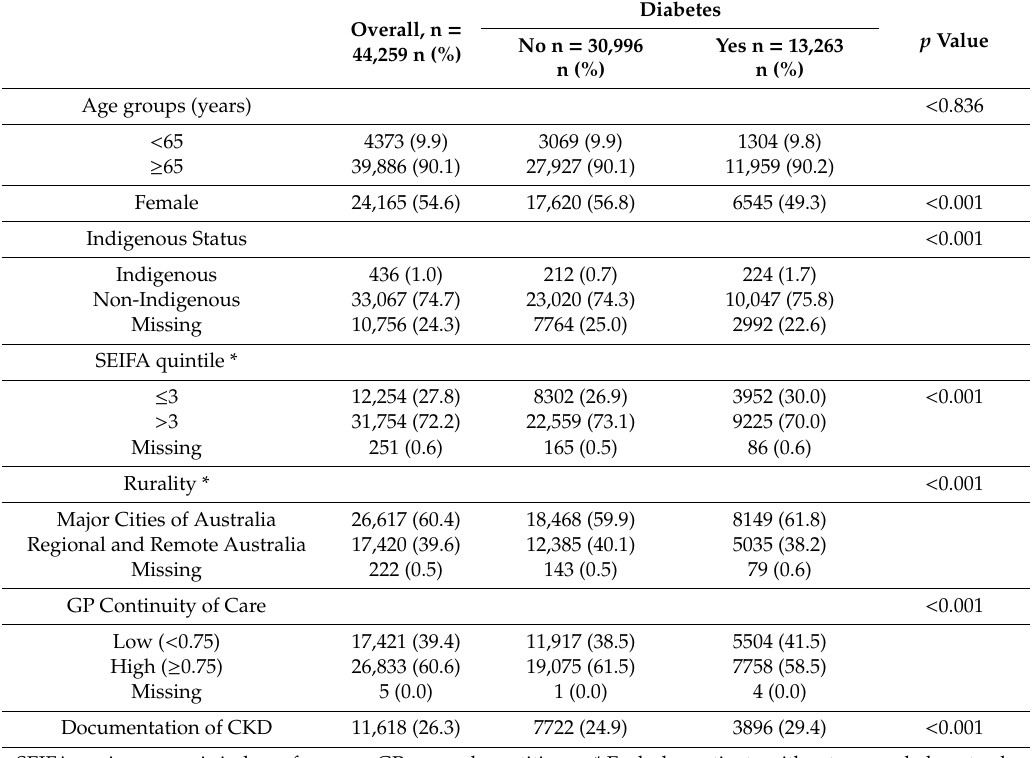
Table 1. Baseline sociodemographic characteristics of patients with chronic kidney disease (CKD) overall and by diabetes status.